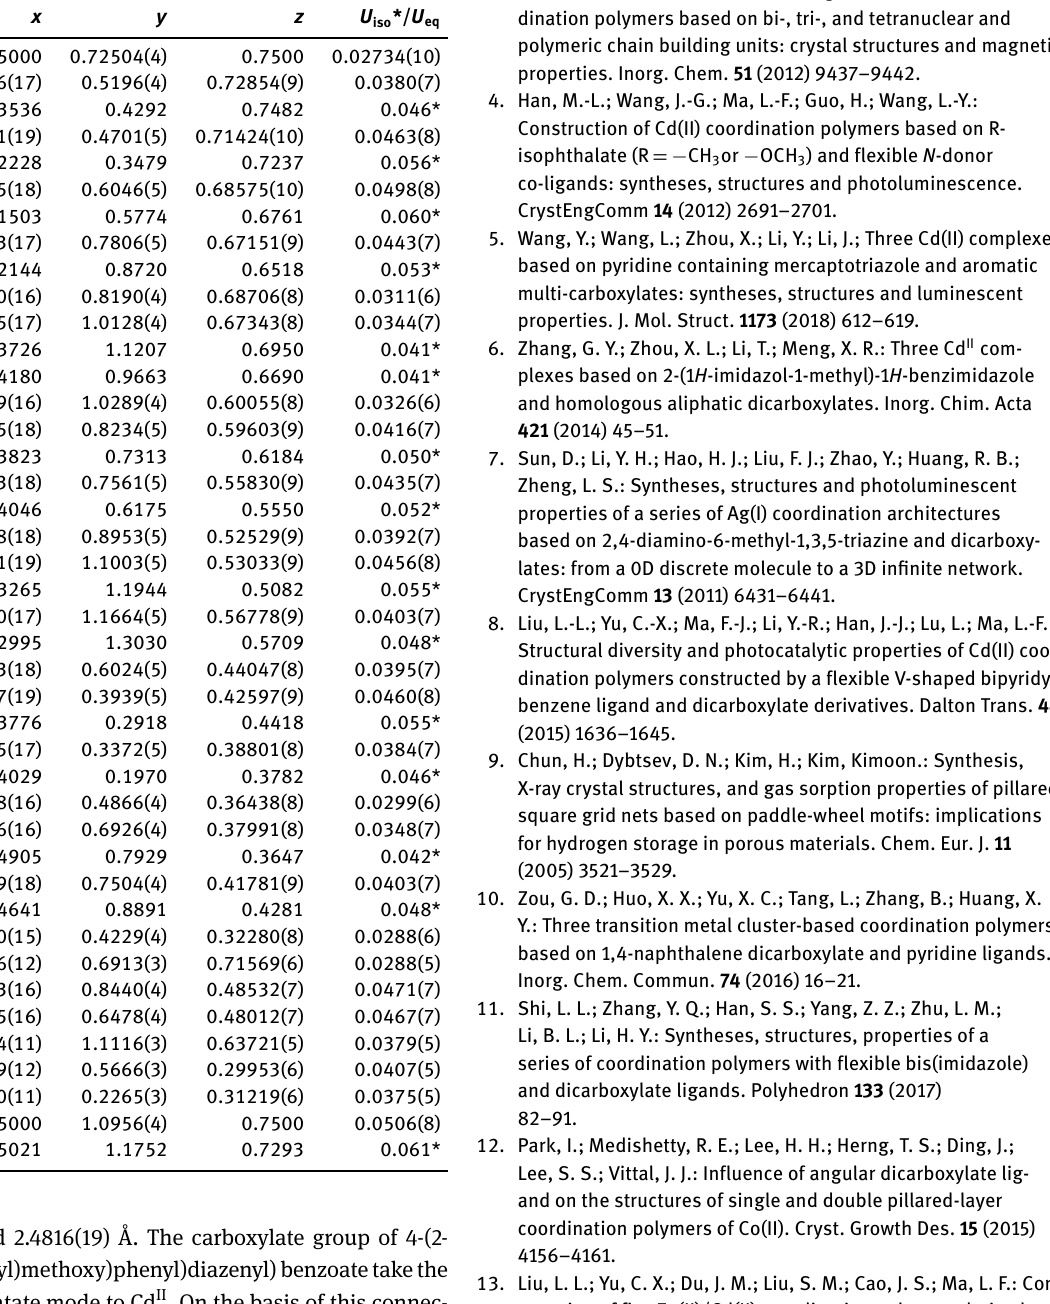
Table 2: Fractional atomic coordinates and isotropic or equivalent isotropic displacement parameters (Å 2